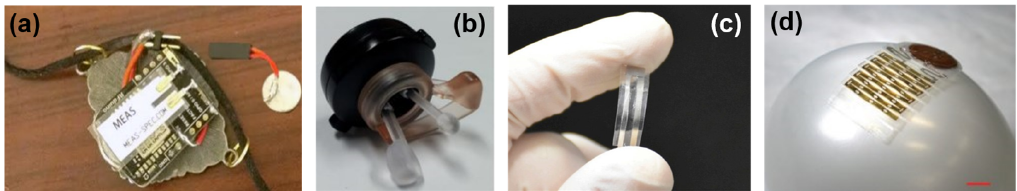
Figure 9. ( a ) Piezoelectric necklace. Reprinted with permission from Ref. [95]. Copyright 2015, Else- vier. ( b ) Pressure-sensing piezoelectric device. Reprinted with permission from Ref. [96]. Copyright 2015, MDPI. ( c ) Biodegradable piezoelectric. Reprinted with permission from Ref. [98]. Copyright 2018, National Academy of Science. ( d ) Installation of the piezoelectric device on a curved balloon. Reprinted with permission from Ref. [23]. Copyright 2019, Wiley.